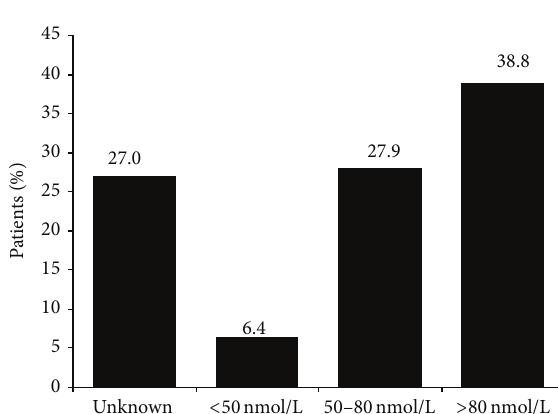
Figure 2: Serum 25(OH)D levels ( 𝑛 = 983 ). Note: numbers may not add to 100 due to